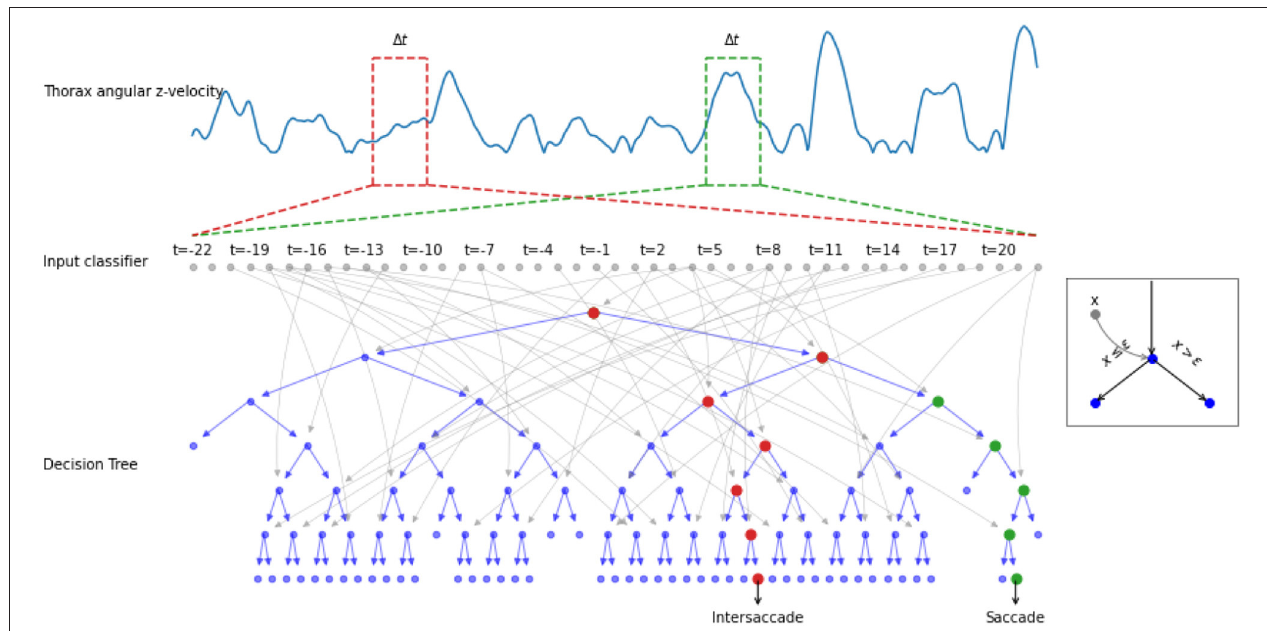
FIGURE 2 | Example of the decision process done by a decision tree. The thorax angular z-velocity (in blue) within a given time window 1 t (e.g., red and green dotted rectangle), is the input of the classifier. A decision tree is composed of nodes (circles), with input x i (gray arrows). If the input x i is greater or equal to a learned threshold ǫ , the right node is selected, otherwise the left (see example in the gray square). The process is repeated until a decision saccade/intersaccade can be drawn. The red (resp. green) node highlights the decision path for an intersaccade (resp. for a